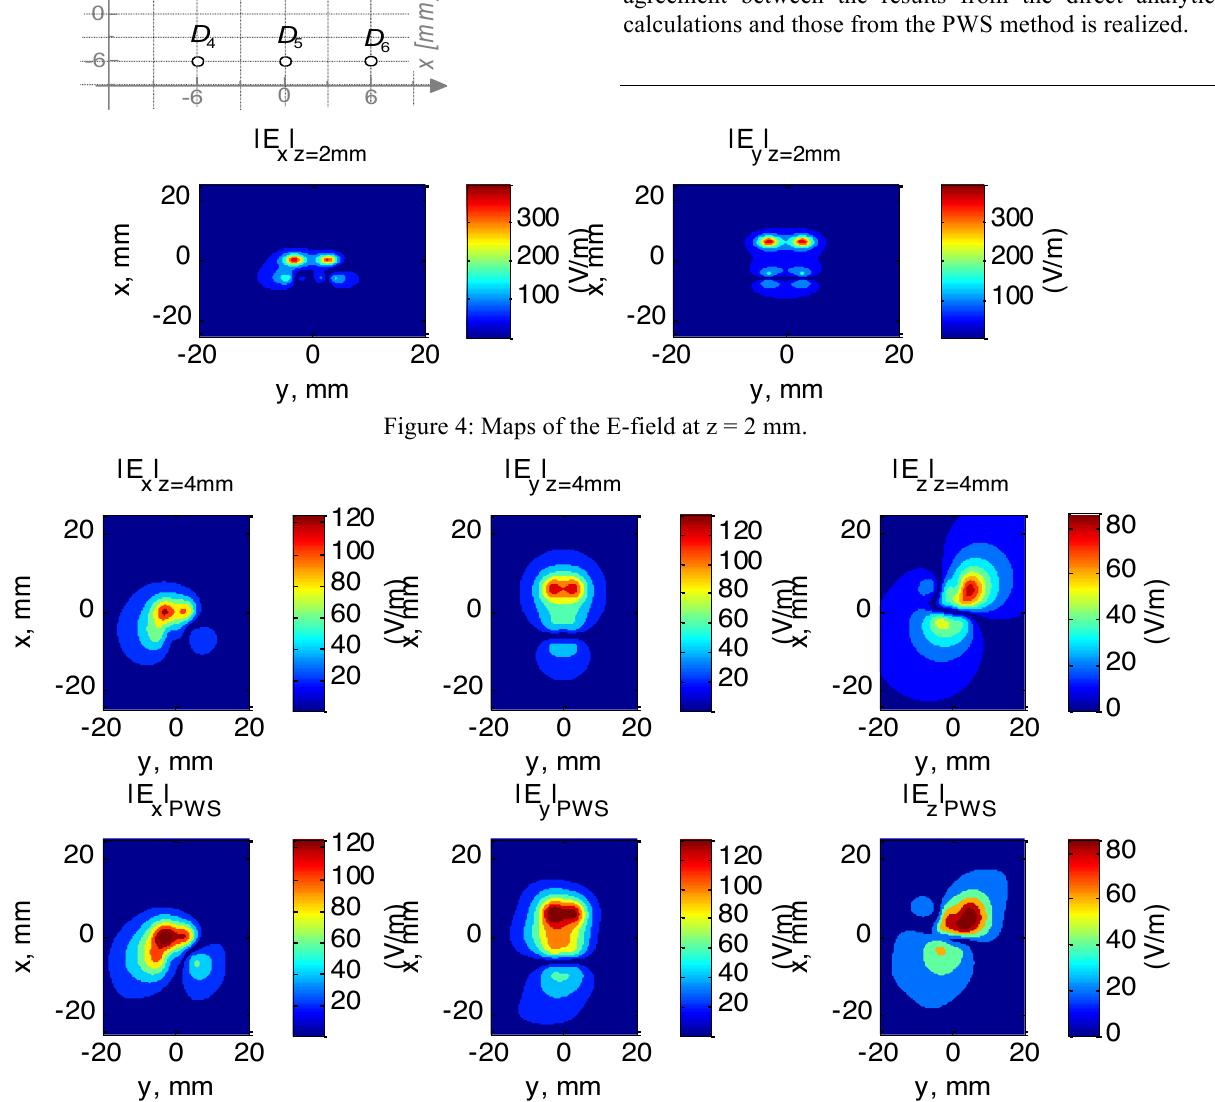
Figure 5: Comparisons of the E-field maps computed directly from the analytical defintion and from the PWS method proposed at z = 4